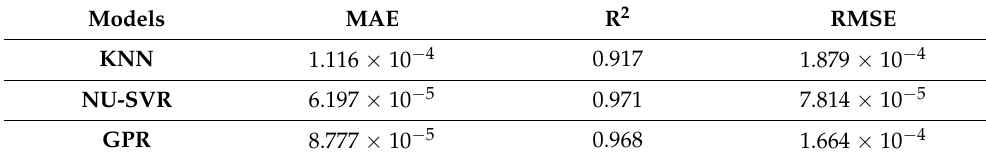
Table 4. The outputs.